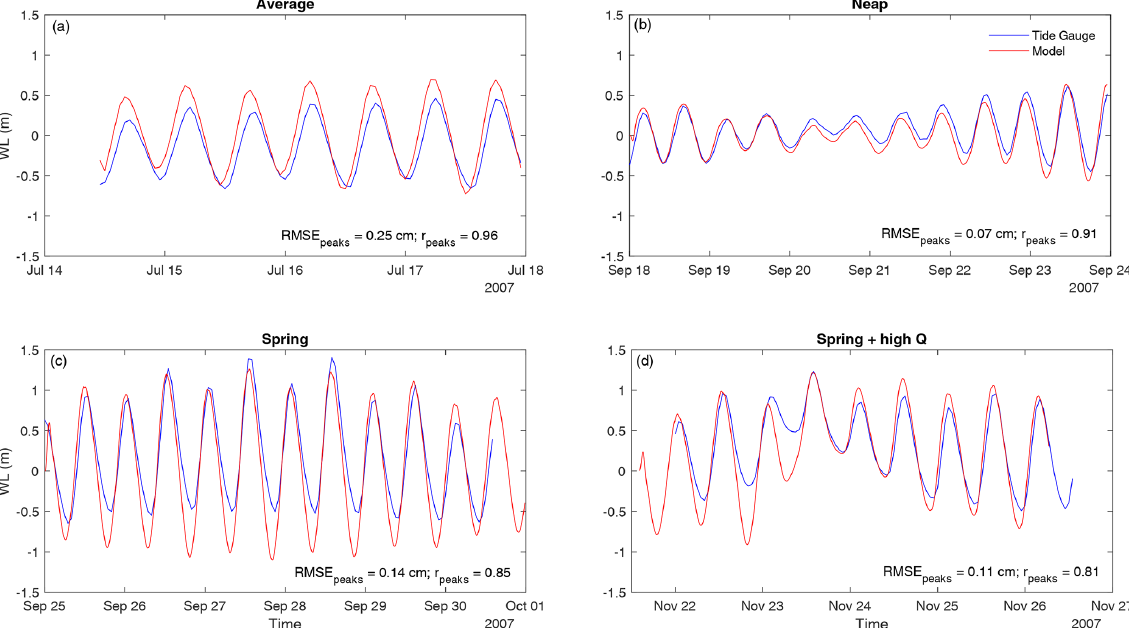
Figure 3. WLs of the model validation runs (red curve) at the tide gauge station compared to observed WLs from the tide gauge (blue curve). Panel (a) shows WLs of the average tide event, (b) the neap tide event, (c) the spring tide event, and (d) the high river discharge event, coinciding with the spring high tide. All panels include goodness-of-fit estimates for peak values of each event (RMSE peaks , r peaks ).